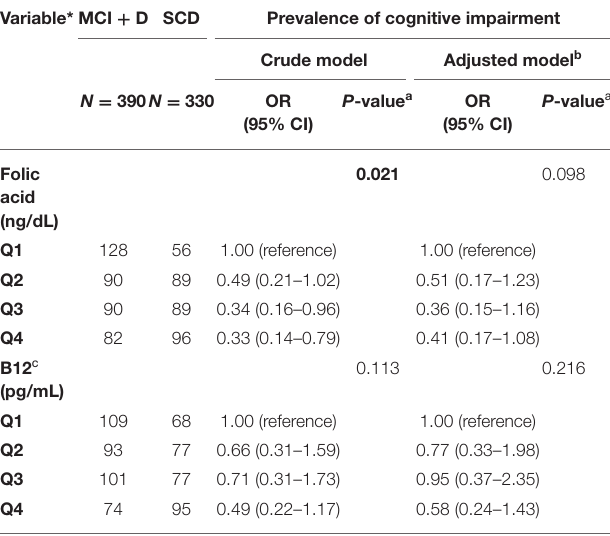
TABLE 6 | Odds ratio (OR) for the prevalence of cognitive impairment by quintiles of serum folic acid and vitamin B12 concentrations. Instituto Peruano de Neurociencias,